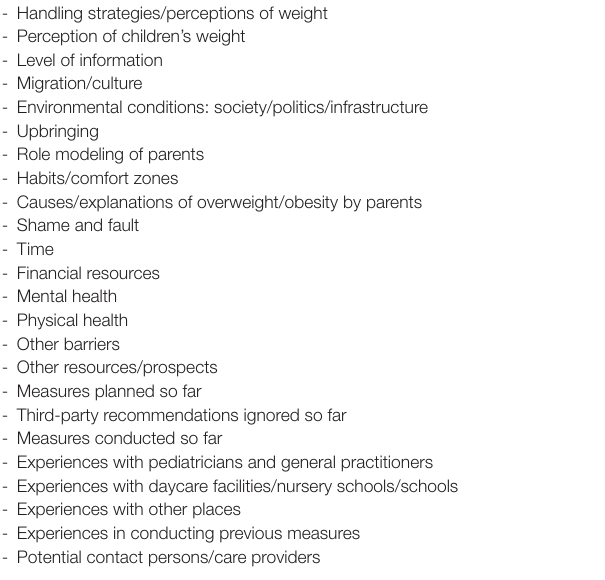
TABLE 1 | Demographics of participating families. TABLE 2 | Main categories of the final category